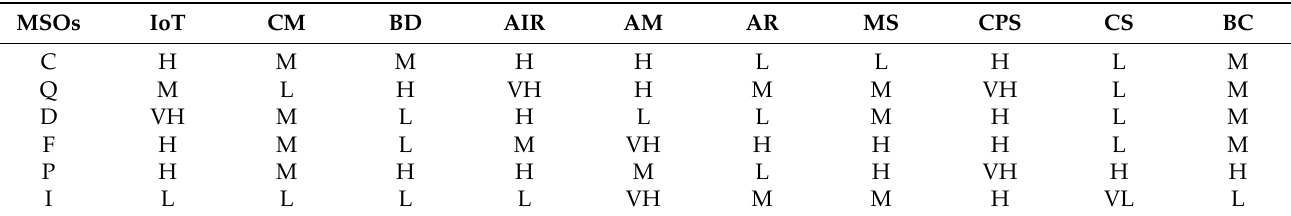
Table 8. An example of collected data.